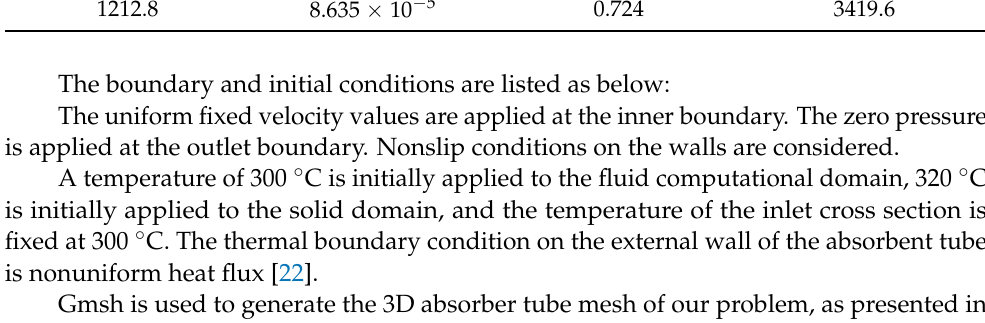
Table 1. Physical properties of 4% CuO nanofluid.